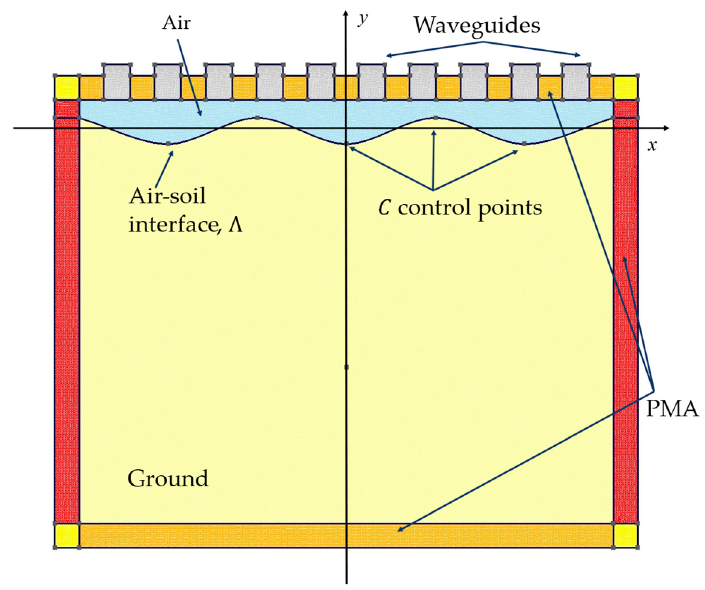
Figure 14. Measurement and subsurface model in the forward solver.